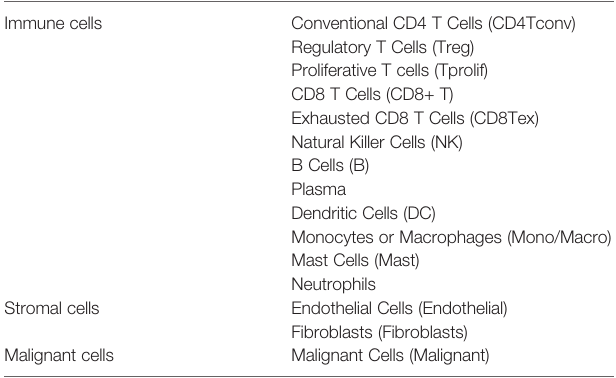
TABLE 4 | The tumor microenvironment includes immune cells/in fl ammatory cells, stromal cells, and malignant cells. Immune cells Conventional CD4 T Cells (CD4Tconv) Regulatory T Cells